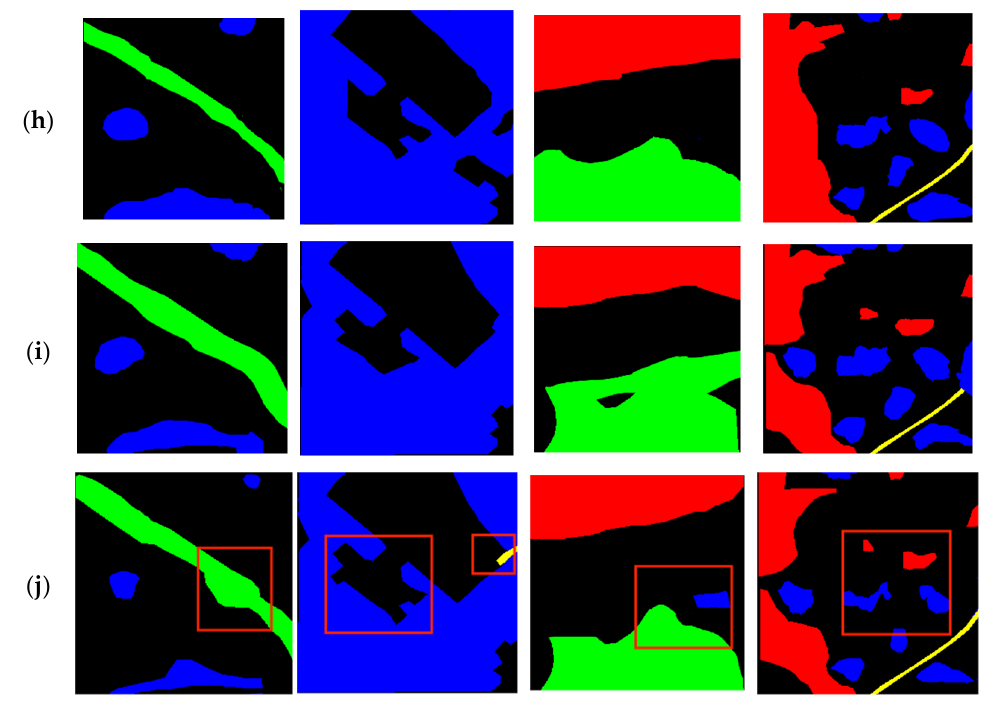
Figure 6. Comparative figure of improvement effects of different attention mechanisms: ( a ) SAR image, ( b ) optical image, ( c ) tag image, ( d ) Deeplabv3+, ( e ) +SE, ( f ) +GALA, ( g ) +CBAM, ( h ) +ECA- Net, ( i ) +MS-FPN, ( j ) +CA.